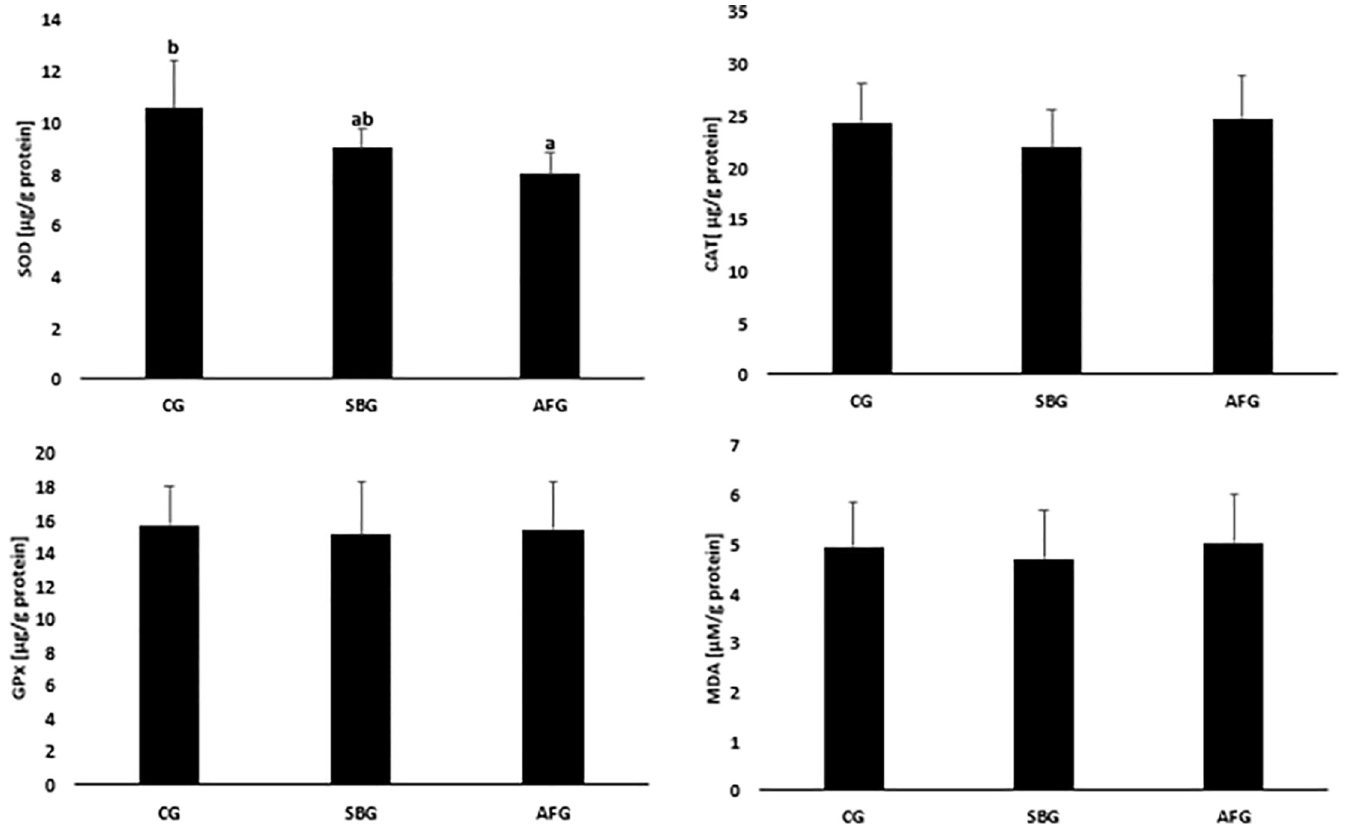
Fig 2. Effect of sucrose content diet and alternating feeding on ovarian superoxide dismutase (SOD), catalase (CAT), glutathione peroxidase (GPx) activities and malonyldialdehyde (MDA) concentrations. CG—Control Group, SBG—Sucrose Balanced Group, AFG—Alternately Fed Group, a,b -Columns marked with different letters are statistically different, p �